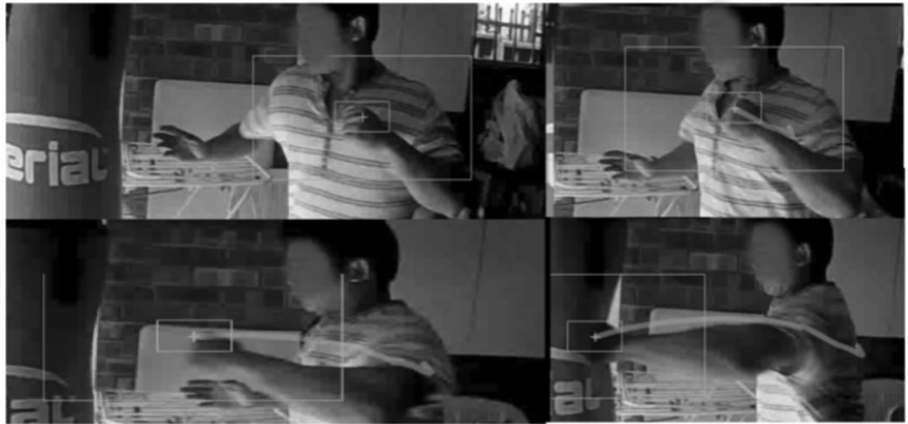
Figure 4. Kinovea motion tracking example